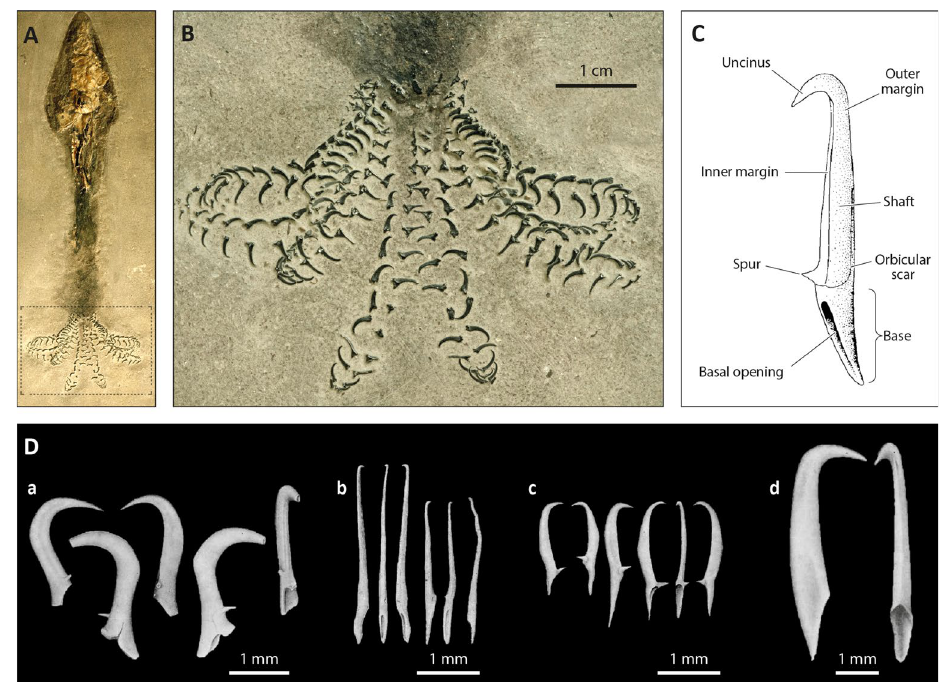
Figure 5. Examples of extinct belemnoid onychites. ( A ) Hook bearing belemnoid specimen, AMNH 046611. ( B ) Close up image of AMNH 046611, brachial crown. ( C ) Schematic drawing of a fossil arm hook with particular morphological elements and their terminology modified from Kulicki & Szaniawski 34 . ( D- ) Examples of different onychites identified by Kulicki & Szaniawski 34 : Falcuncus falcus onychites (a); Longuncus longus onychites (b); Paraglycerites gracilis onychites (c); Deinuncus brevirostris onychites